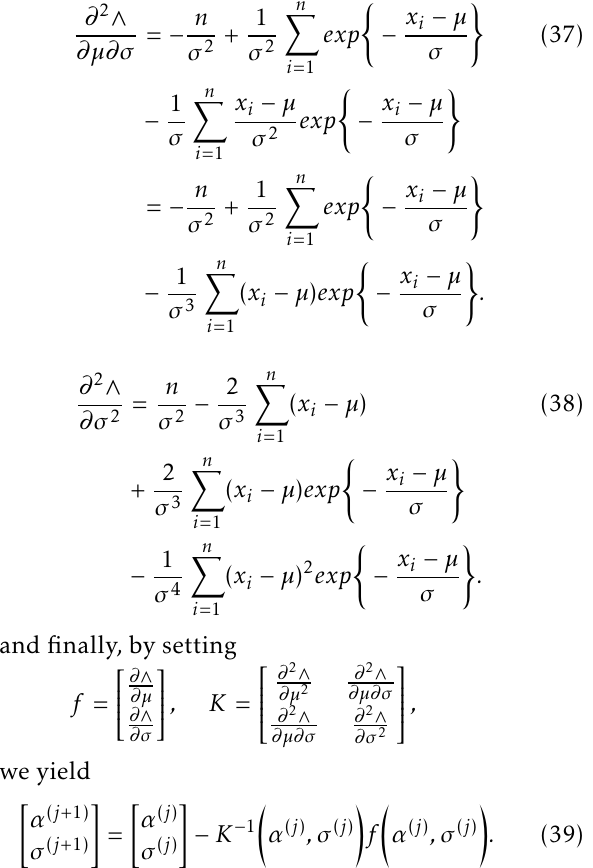
Table 3. Maximum salinity peak in Ca Mau